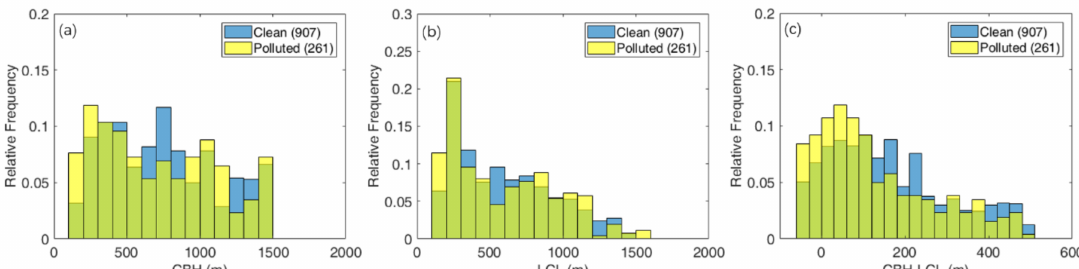
Figure 5. Distributions of ( a ) cloud base height; ( b ) lifting condensation level; and ( c ) the difference between cloud base height and lifting condensation level CBH–LCL at BWI station under clean and polluted aerosol conditions. The number in the parentheses is the number of cloud cases. The light-green color shows overlap in the relative frequencies of the two